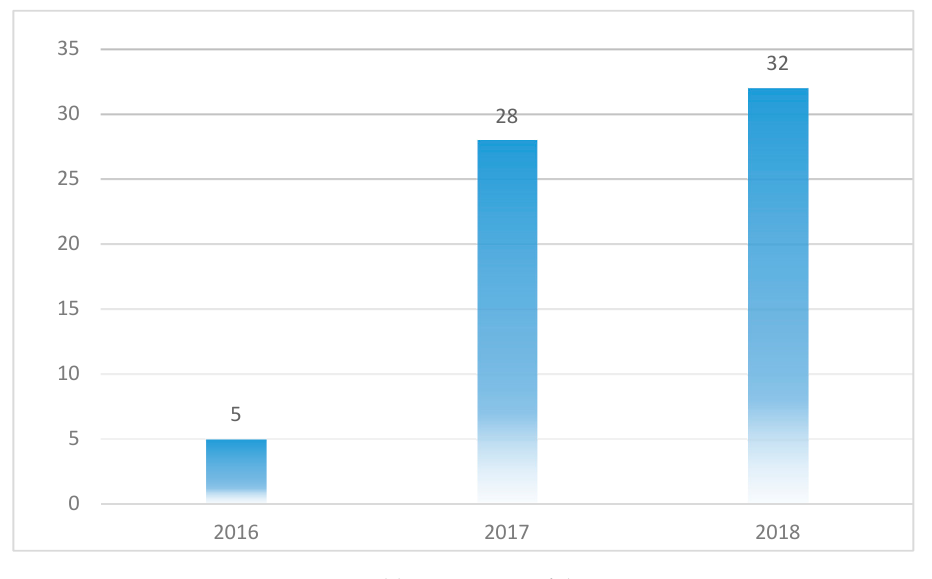
Figure 6. Publication years of the papers.